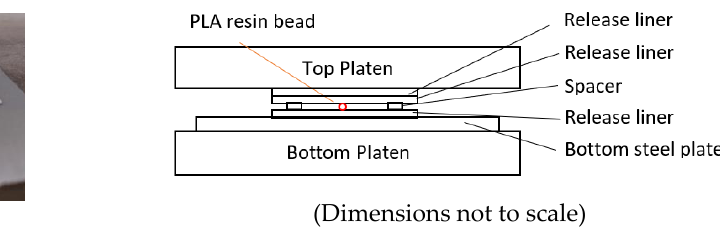
Figure 17. Pictorial and schematic of hot press and key components for porosity measurements.